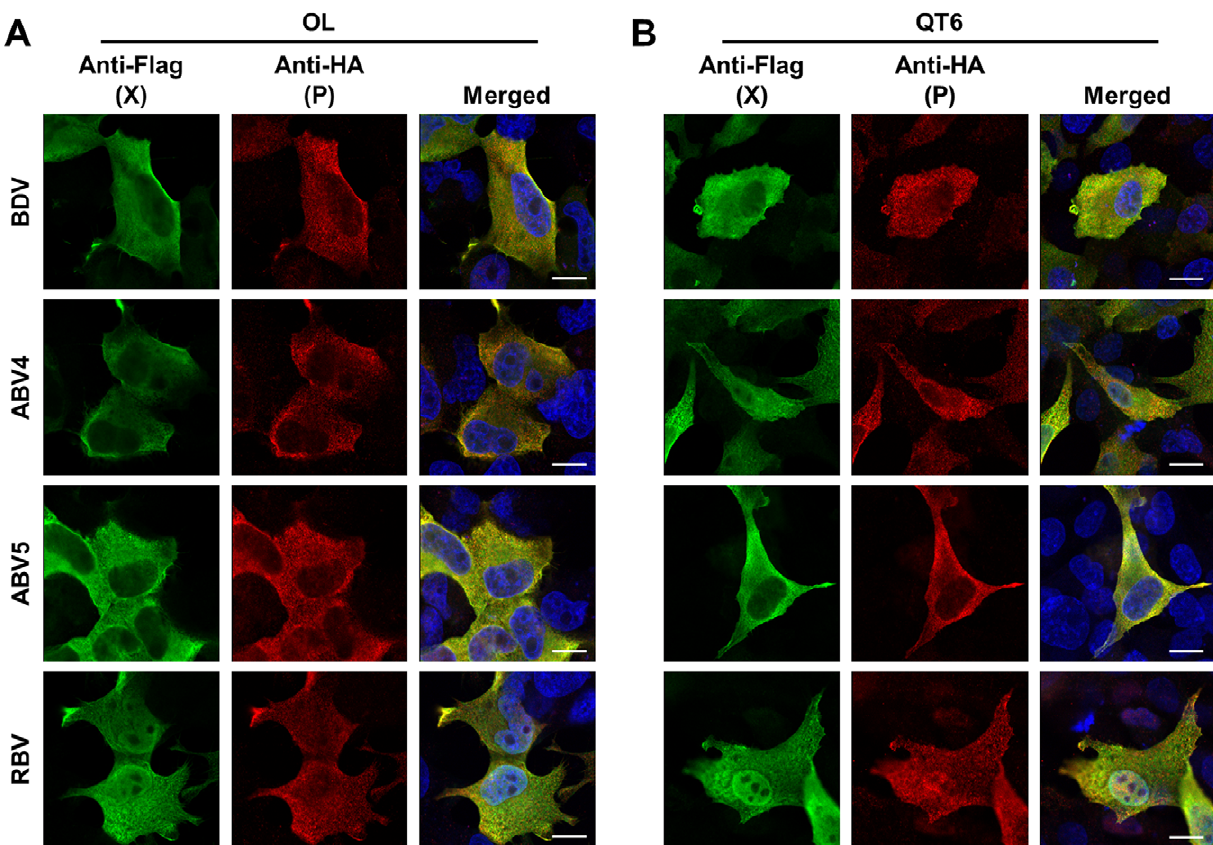
Figure 4. Nuclear export of P in the cells co-expressing the X protein. The X and P expression plasmids of each bornavirus genotype were co-transfected into OL (A) and QT6 (B) cell lines, and the intracellular distribution of the viral proteins was determined by immunofluorescence analysis. The recombinant X and P proteins were detected by anti-Flag (green) and -HA (red) antibodies, respectively. Merged images with DAPI staining are indicated. Scale bars are 10 m m.